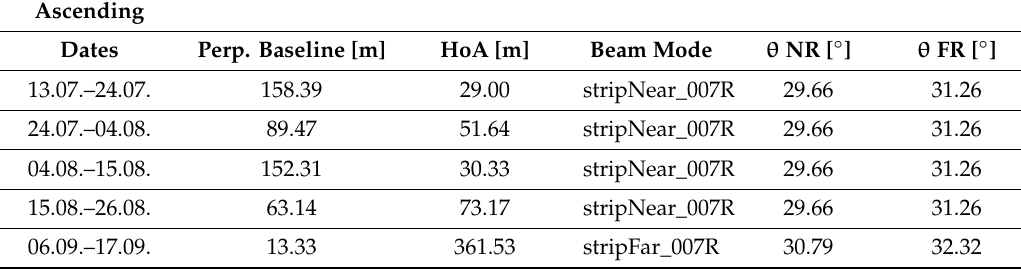
Table 2. TS-X data and the di ff erent acquisition parameters from 2015 used in the study. (Date format = DD.MM.2015. Perp. baseline = perpendicular baseline, HoA = height of ambiguity, θ = incidence angle in far range (FR) and near range